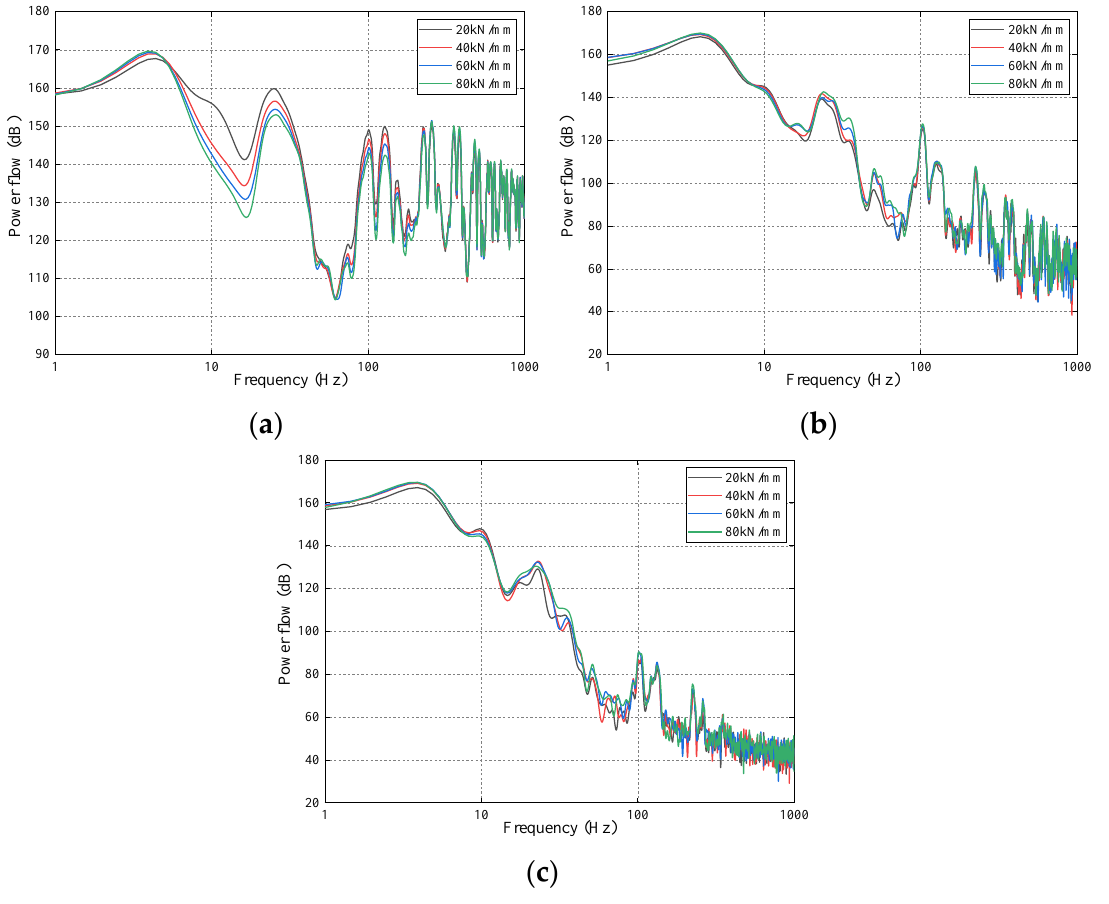
Figure 10. The power flows of ( a ) the rail, ( b ) the slab track, and ( c ) the bridge. Figure 12. The power flows of ( a ) the rail, ( b ) the slab track, and ( c ) the